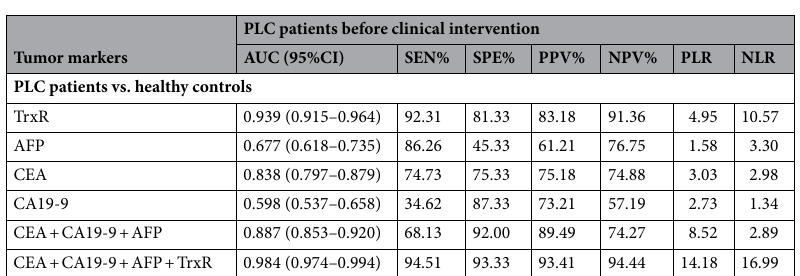
Table 1. The diagnostic efficiency of TrxR, CA19-9, CEA , AFP and their combinations in distinguishing PLC patients from healthy controls. SPE: specificity; SEN: sensitivity; NPV: negative predictive value; PPV: positive predictive value;NLR: negative likelihood ratio. PLR: positive likelihood ratio; the diagnosic threshold of TrxR activity was 3.85 U/mL.